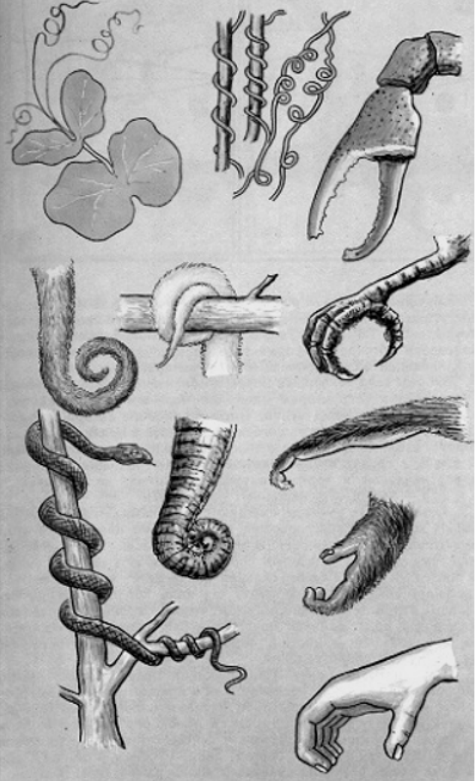
Fig. 10. Use of concave autowaves in biology.